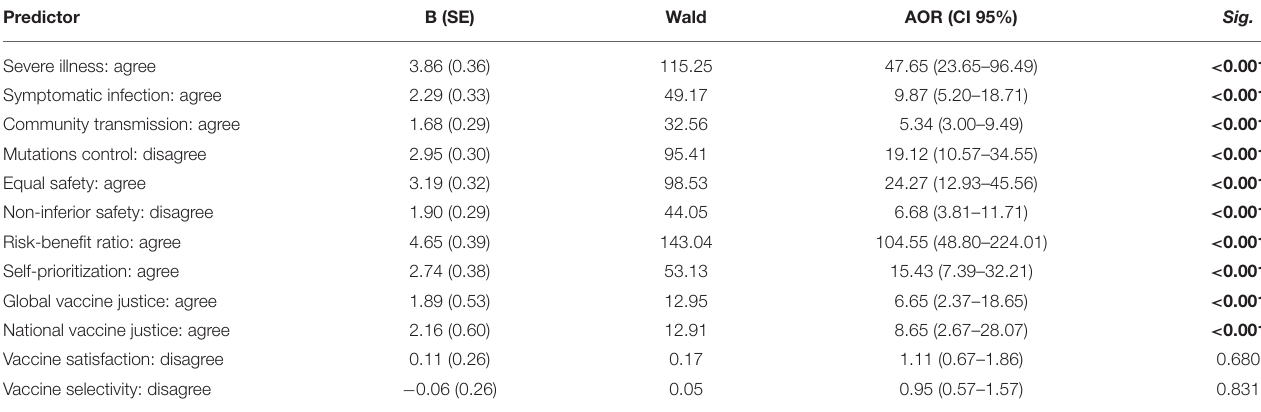
TABLE 8 | Regression analysis of COVID-19 vaccine-related acceptance psychosocial drivers of German university students and employees participating in the COVID-19 Vaccine Booster Hesitancy (VBH) Survey, december 2021 ( n = 930). Predictor B (SE) Wald AOR (CI 95%)